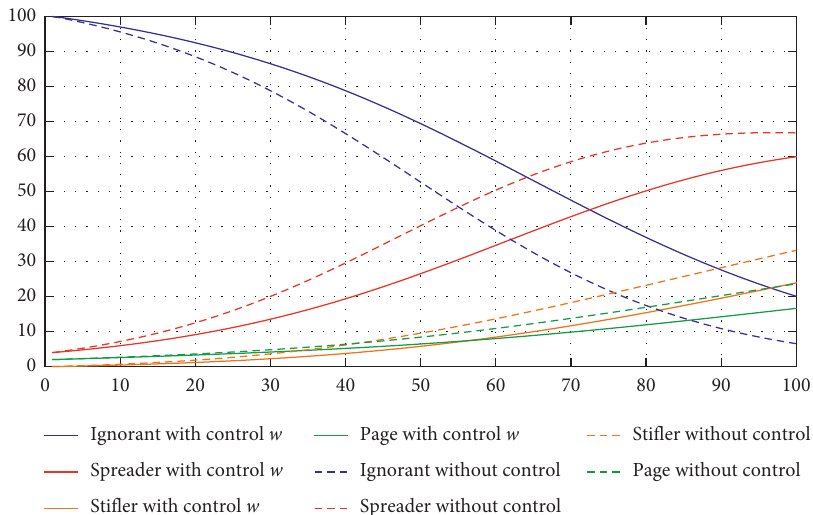
Figure 6: Dynamics with controls w